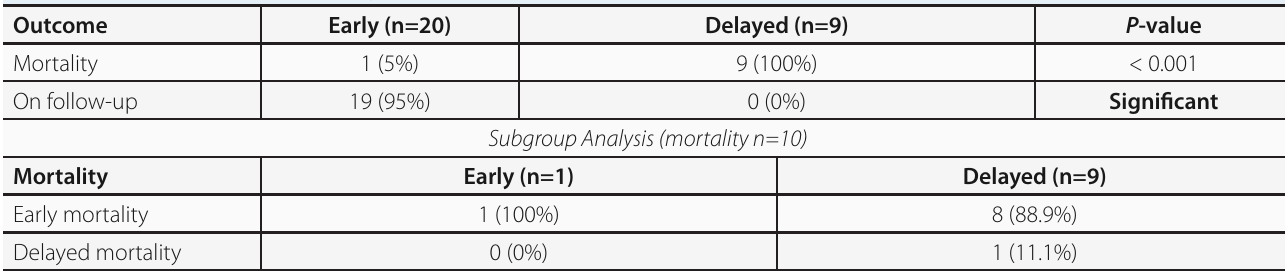
Table 3. Outcome and subgroup